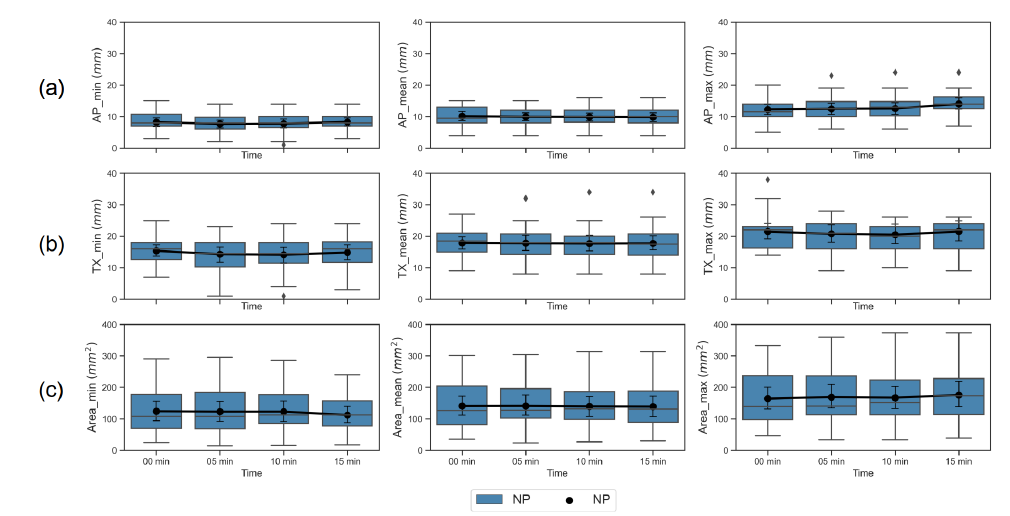
Figure 3. Box plot and a point plot with mean and 95% CI across 22 patients for each of the 9 airway dimensions (listed in Table 1) in nasopharyngeal (NP) plane. Airway measures at the four anesthetic conditions of 00 min (DEX only, baseline), 5, 10, and 15 min after administering ketamine at the baseline condition were plotted on the x-axis. Each of the subplots represent an airway measure, row-wise: ( a ) anterior-posterior (AP) diameter (in mm), ( b ) transverse (TX) diameter in (mm), and ( c ) cross-sectional area (in mm 2 ) at the minimum (min), mean and maximum (max) airway sizes (plotted column-wise) during continuous